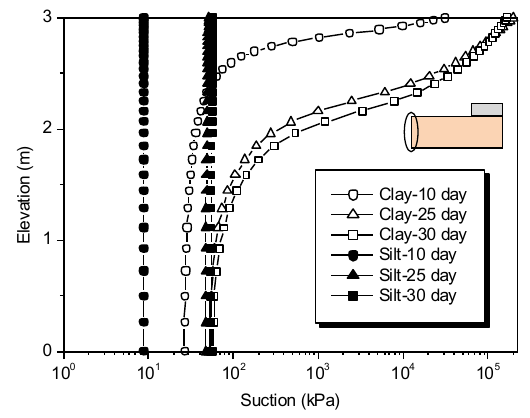
Fig. 13c. Influnce of the soil type on the variation of soil suction.